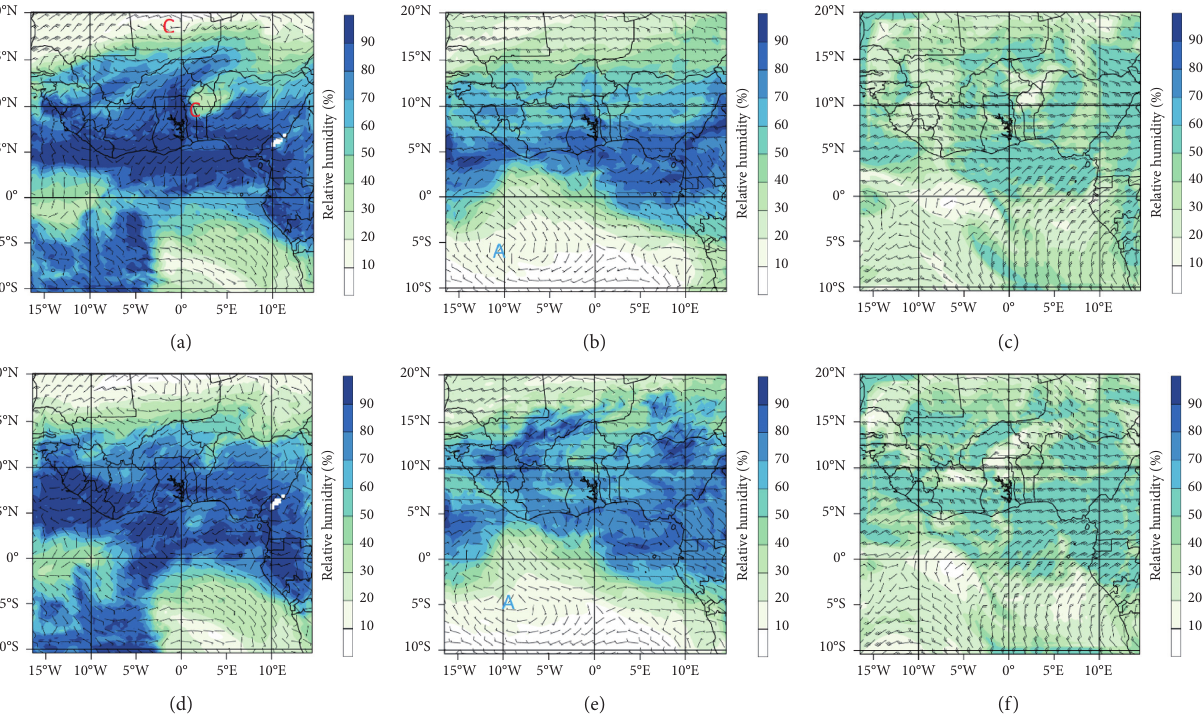
Figure 13: WRF wind speed and direction for 850hPa, 700hPa, and 200 hPa at 12 UTC ((a) (b), and (c)) and 18 UTC ((d), (e), and (f)) for case B.